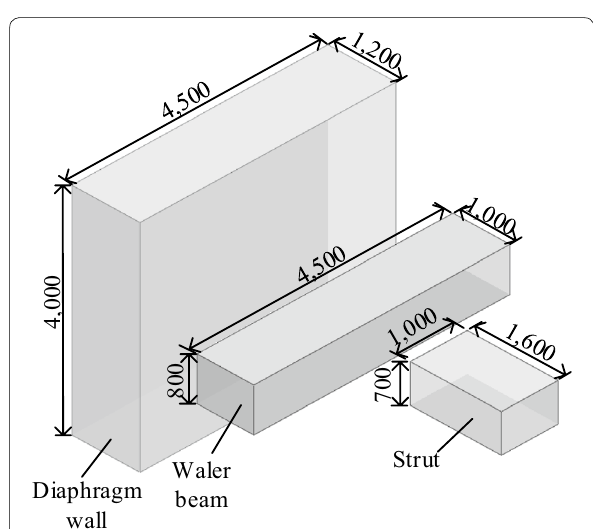
Fig. 2 Configuration of the wall-beam-strut joint (unit: